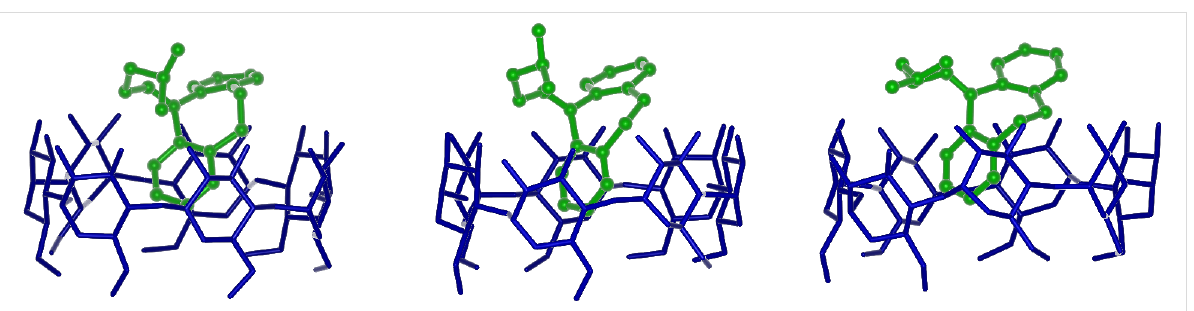
Figure 6: The value of the C9–C10 dihedral angle as a function of time for the complexes of molecule 1 and 2 (left and right, respectively).